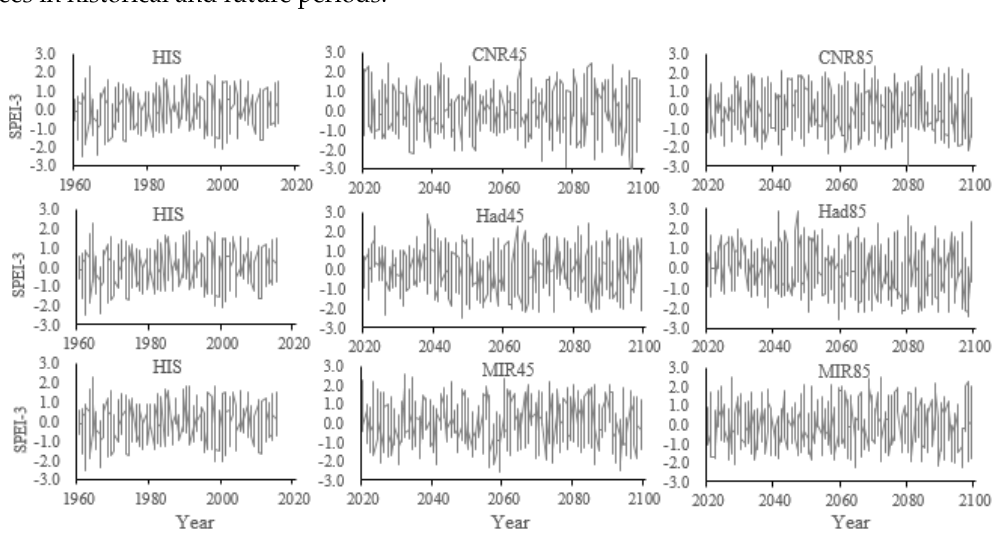
Figure 4. Changes of monthly SPEI index of three-month time scale (SPEI-3) historically (HIS) based on ground observed data and in the future based on the three CMIP5 models projected data under RCP4.5 (45) and RCP8.5 (85) emission scenarios.